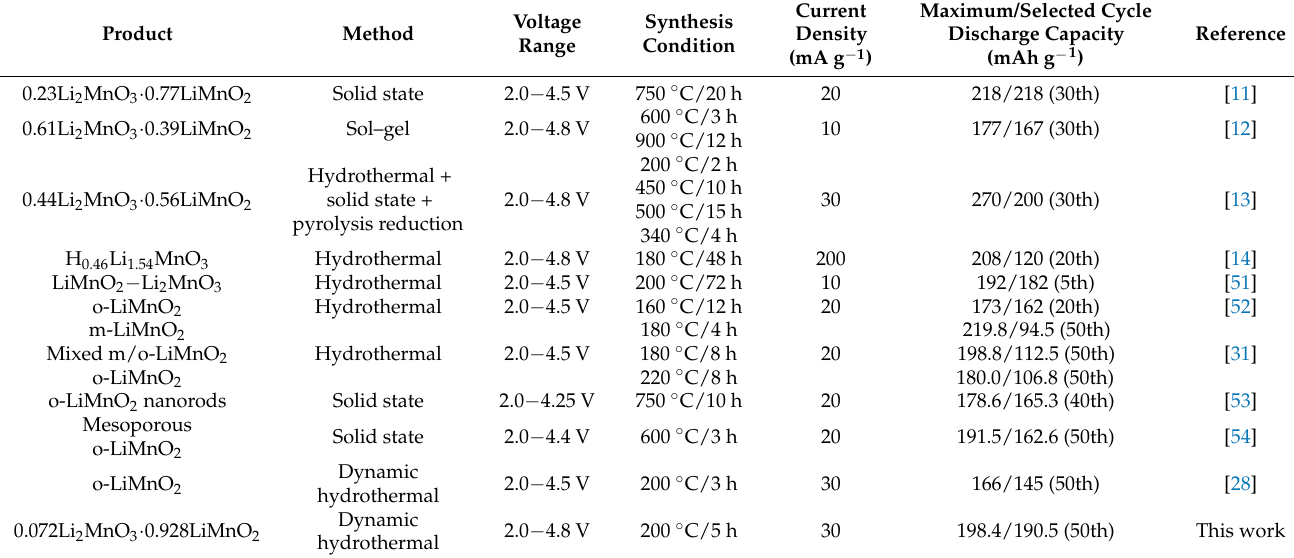
Table 4. Summary of the synthetic conditions and electrochemical properties of the obtained lithium manganese oxide cathode materials prepared using different